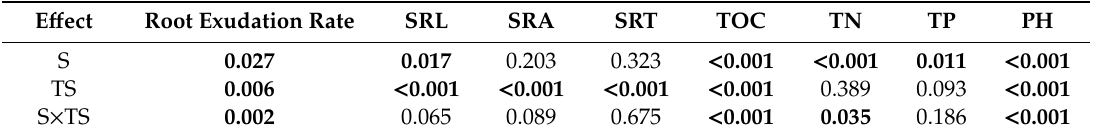
Table 3. Results of ANOVA showing the P values for responses of root exudation rate, specific root length (SRL), area (SRA), and tips (SRT), soil total organic carbon (TOC), total nitrogen (TN), total phosphorus (TP), and pH to site (S) and tree species (TS). p values < 0.05 are bold. E ff ect Root Exudation Rate SRL SRA